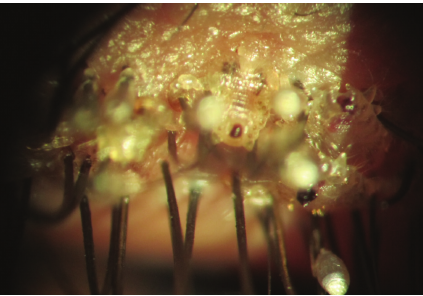
Figure 1: Slit-lamp photo; multiple lice and nits anchored at the eyelashes (pretreatment).